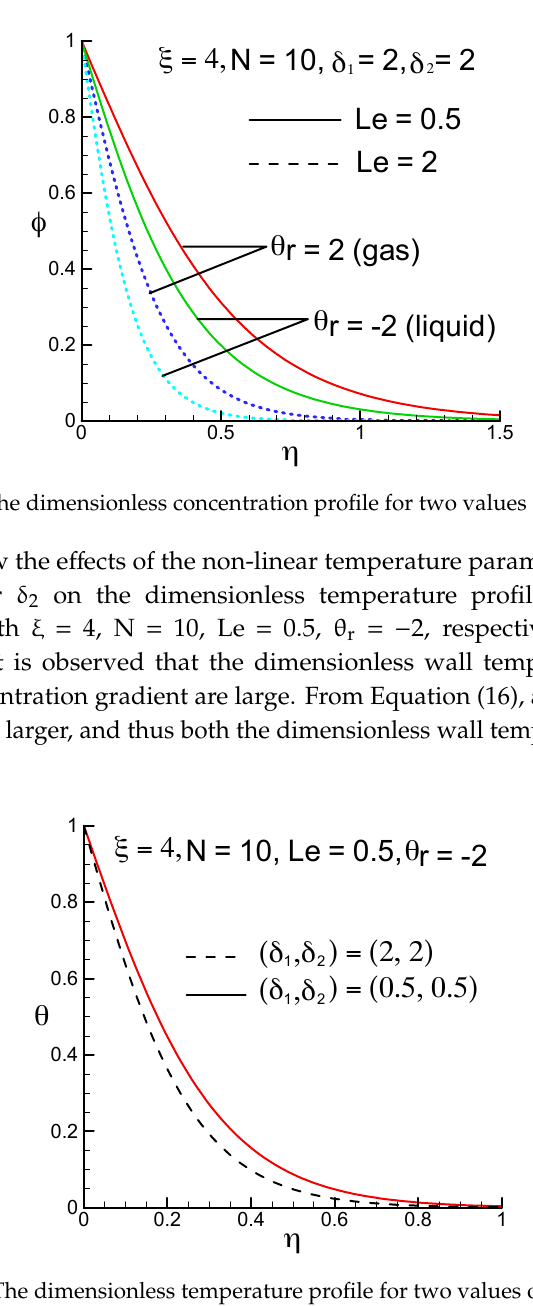
Figure 2. The dimensionless temperature profile for two values of Le and r  .